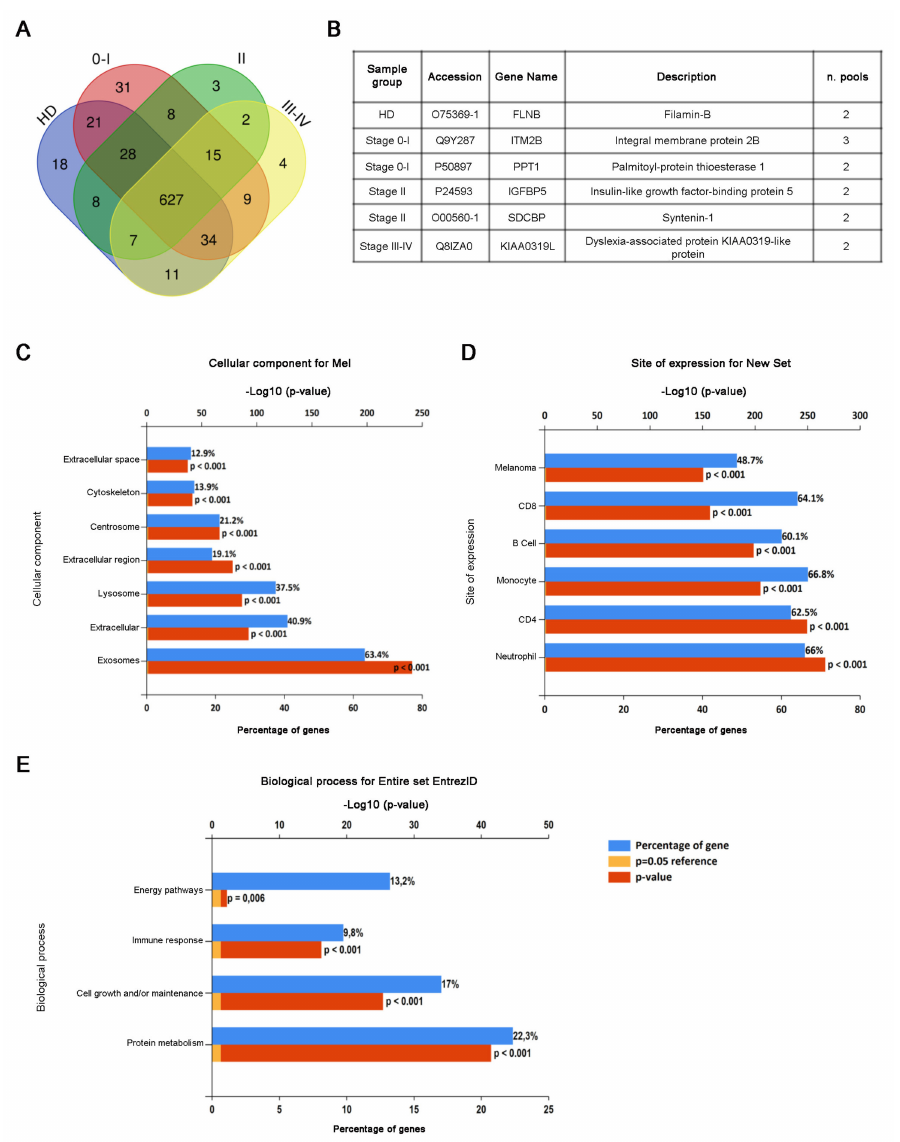
Figure 3. Proteomic analysis of CD81sEV. ( A ) A Venn diagram representing the number of proteins uniquely detected in each HD, stage 0–I, stage II or stage III–IV group or shared among two, three or four-sample groups. ( B ) A table of proteins identified at least in two pools uniquely in one sample group. ( C – E ). Enrichment analysis of identified proteins by FunRich analysis for cellular component ( C ) site of expression ( D ) and biological process ( E ). Blue bars represent the percentages of protein genes assigned to the indicated terms. Yellow bars show the reference p value (0.05), and red bars show the calculated p value of enrichment for the indicated